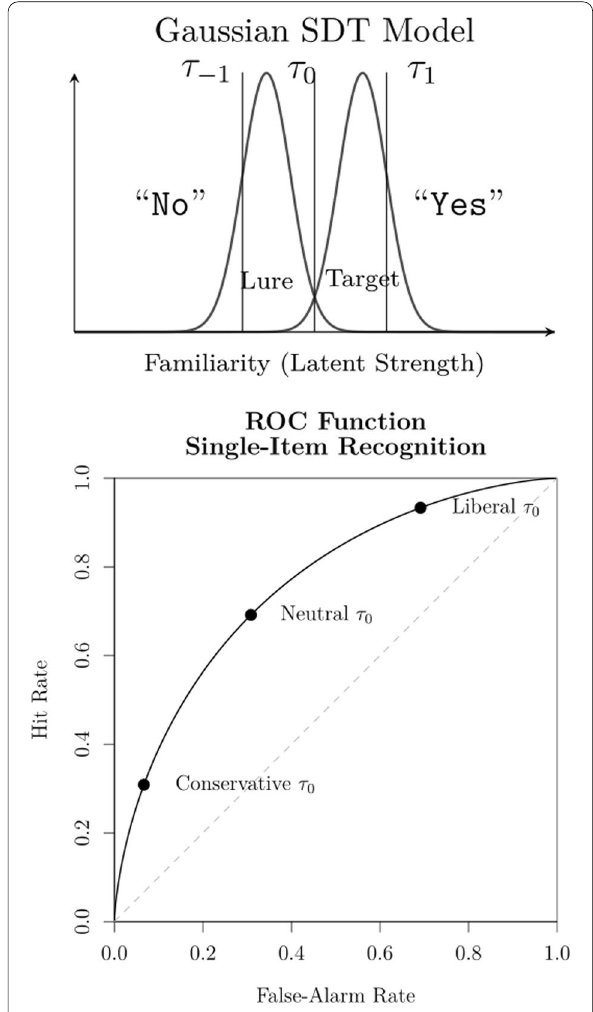
Fig. 1 Top panel: Illustration of the Gaussian SDT model. The vertical lines represent the response criterion τ 0 and the confidence criteria τ − 1 and τ 1 . Bottom panel: Example of a ROC function for the case of single-item